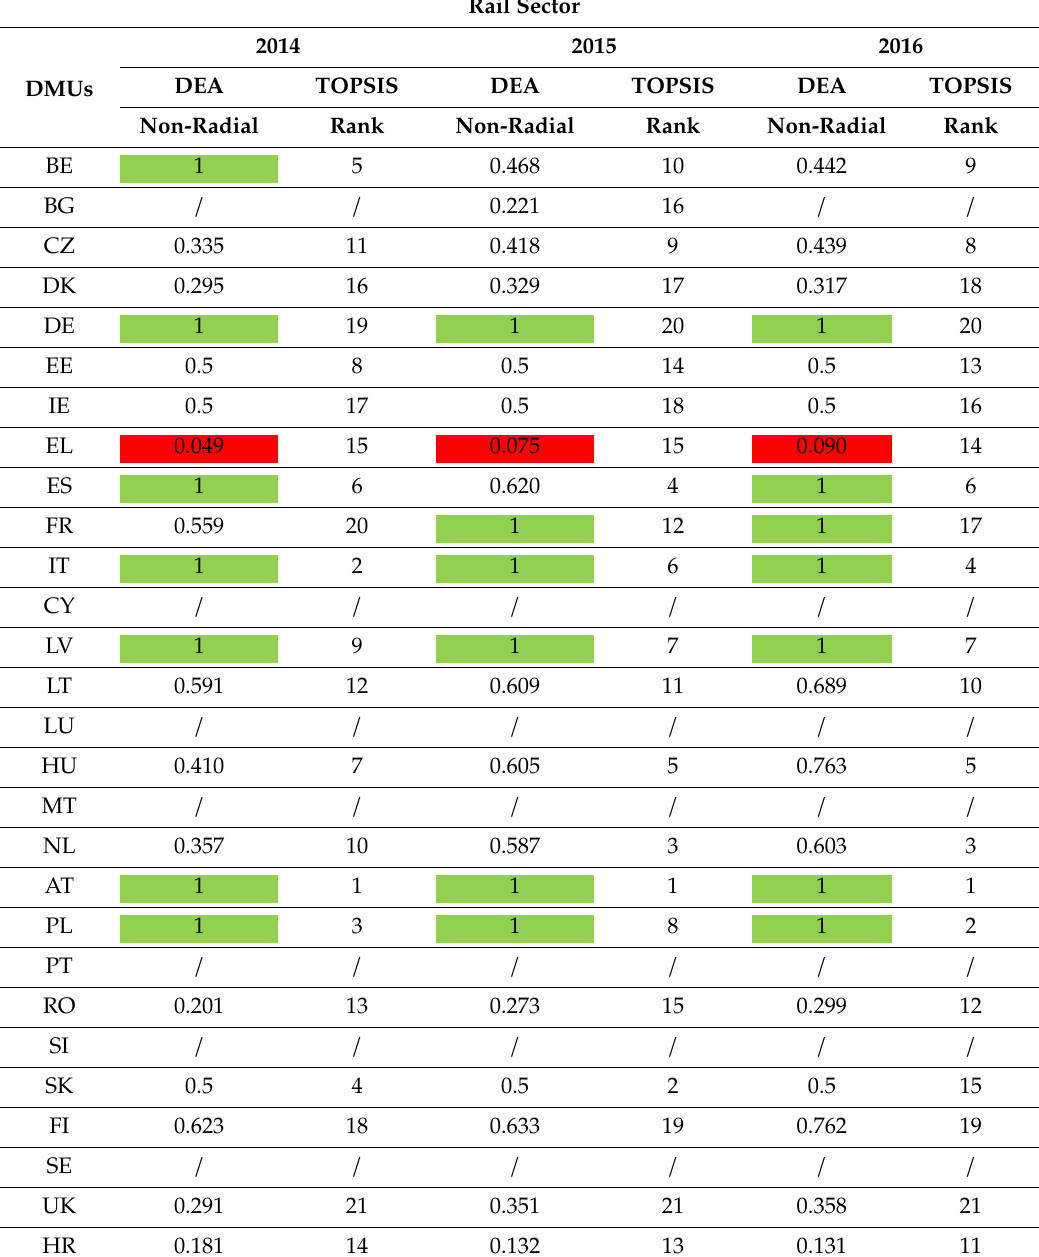
Green color: the best EEEI . Red color: the least EEEI